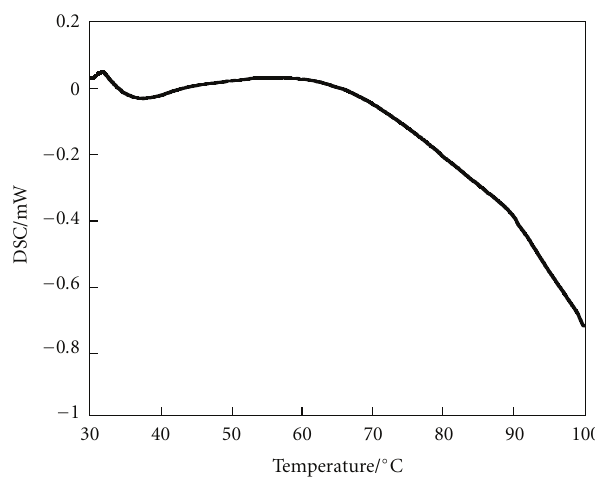
Figure 3: Di ff erential scanning calorimetry of PAA/MB fiber.